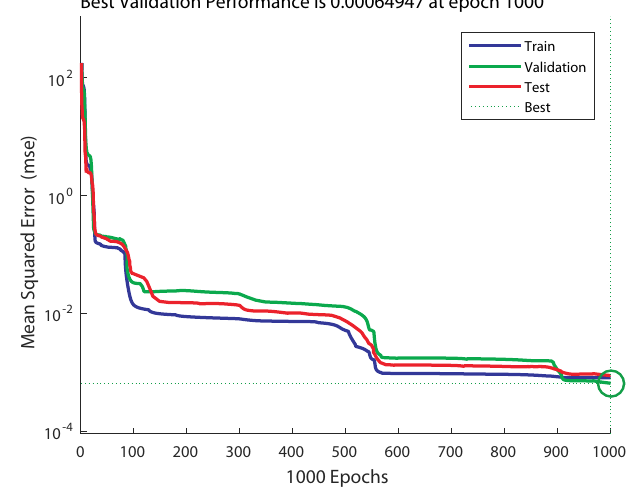
Figure 11. Training performance for a network of 2 × 2 × 4 × 1